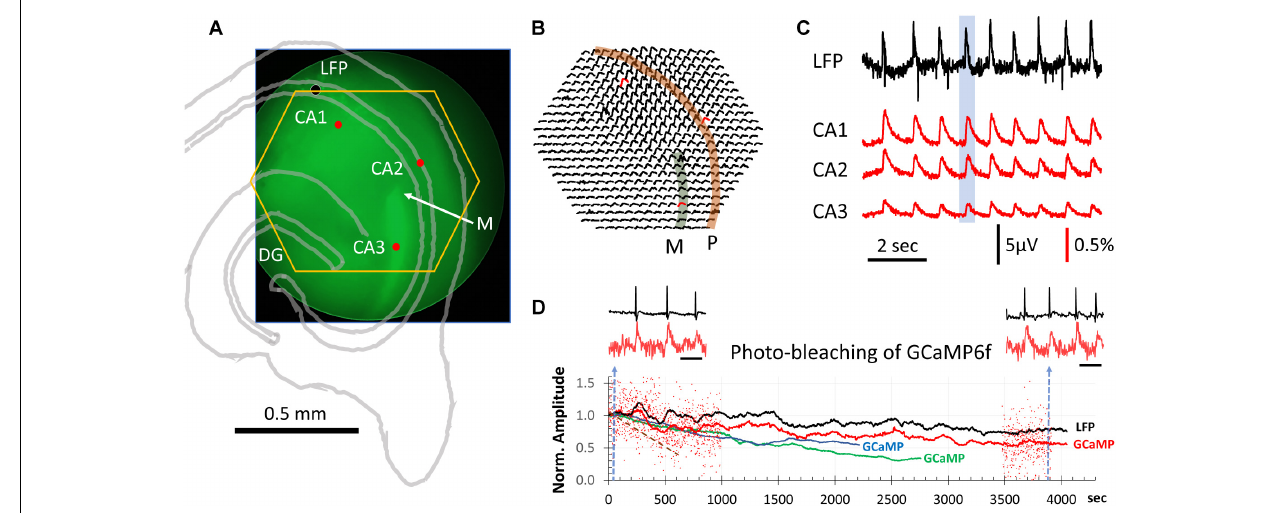
FIGURE 1 | GCaMP population signals of SWs across hippocampal subfields. (A) Slice positioning over the diode array. The end of mossy fibers (M) and lack of GCaMP6f expression in CA2 was used to identify the three hippocampal subfields CA1-3. The yellow hexagon marks the field of view of the diode array. The black dot marks the location of the LFP electrode. These structures were also outlined with an image of transmitted light (gray lines). (B) (cid:49) F / F from all 464 diodes during a SW event. This SW was one of the 9 occurring during a 9-s recording sweep (blue box in C ). Note that GCaMP signals of SWs were seen over a large area across CA1, CA2, and CA3. Str. pyramidale (P, orange band) and mossy fiber bundle (M. f\green band) are identified overlaying the signals. (C) LFP signals were simultaneously recorded with the GCaMP signals (both sampled at 1,616 Hz). Signals from three detectors in CA1, CA2 and CA3 [red dot/traces in panels (A,B) ] plotted together with the LFP recording (filtered 0.1–30 Hz). The amplitude of SWs in the GCaMP signal were on average 0.3% (cid:49) F / F with a signal-to-noise > 10. From 11 slices we recorded ∼ 6,500 SW events optically, all with a clear one-to-one correspondence between LFP and optical GCaMP signals. (D) Decline of optical signals over long recording periods due to photobleaching. Red dots mark the relative amplitude of individual SWs from one slice recording. For clarity, events are only shown for the first 1,000 and last 500 s. The relative (cid:49) F / F amplitude is normalized to the average amplitude of the first 100 events at the beginning of light exposure. Black and red traces are averages of the LFP and GCaMP signals, respectively, in a sliding 100-event window. Blue and green traces are GCaMP signals from two additional animals. Brown broken line: another slice with exposure at 6 times the light intensity for 660 s. Left and right insets: LFP and GCaMP signals from one slice before and after 4300 s of continuous light exposure. Blue broken line in panel (D) marks the sample time of the two traces. Note that amplitude reduction due to photobleaching is not obvious in individual SWs, as spontaneous SWs have a large variation in amplitude. Scale bar for inset = 1